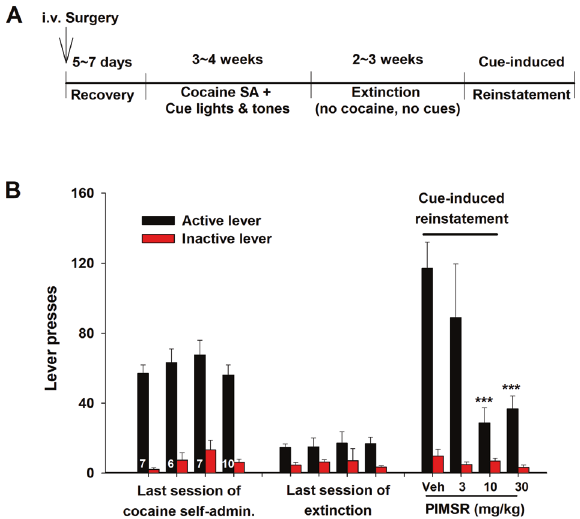
Fig. 3 Effects of PIMSR on cue-induced reinstatement of cocaine seeking in rats. A General experimental procedures for cue-induced reinstatement of cocaine seeking; B The averaged active and inactive lever responses during the last three days of cocaine self- administration, the last three days of extinction, and reinstatement testing. PIMSR, when administered 30 min prior to reinstatement testing, dose-dependently reduced cue-induced reinstatement of cocaine-seeking behavior ( n = 6 – 10 per group). *** p < 0.001, com- pared to